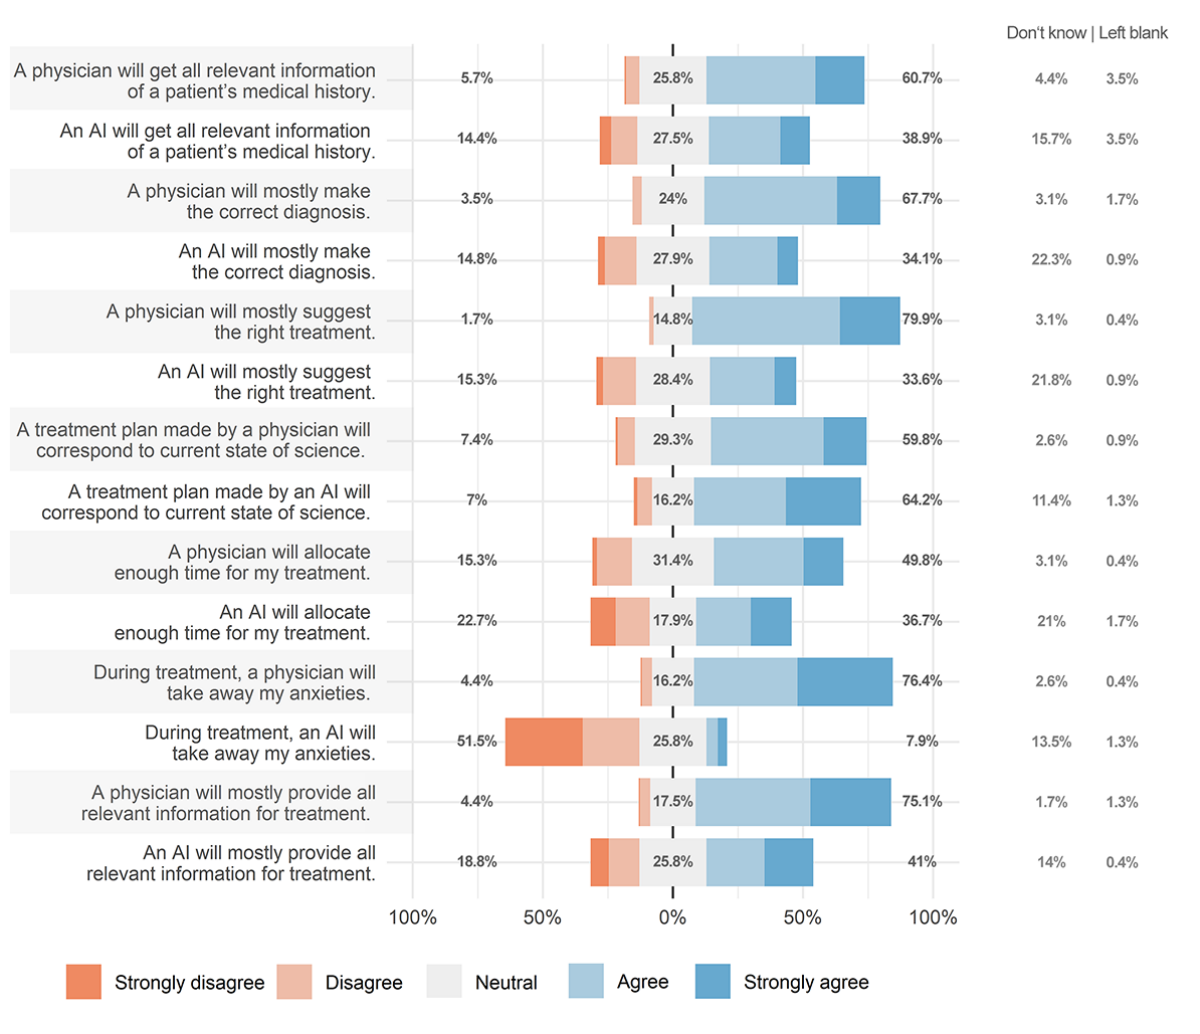
Figure 1. Results of the questionnaire regarding the clinical capabilities of physicians versus artificial intelligence (AI). Percentages refer to the proportion of negative (light orange, orange), neutral (gray), and positive (light blue, blue) responses. Proportions of patients who indicated “Don’t know” or left the question blank are indicated on the right. Patients favored physicians to AI for all clinical capabilities except for making a treatment plan based on current clinical knowledge, where they preferred an AI